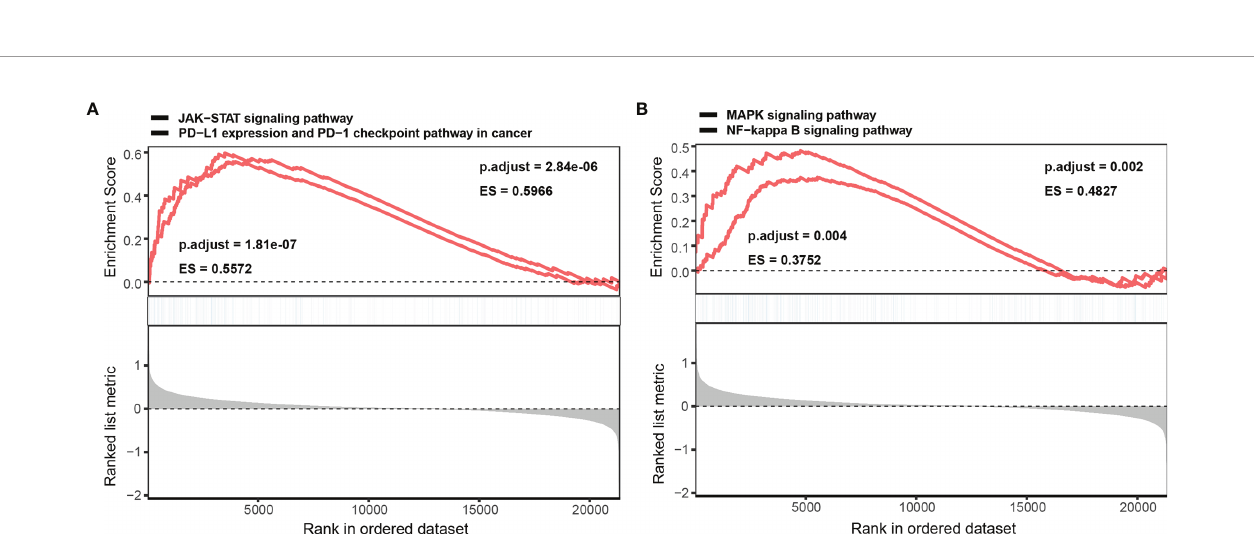
FIGURE 6 | GSEA enrichment analysis of NINL. Single gene GSEA enrichment analysis of NINL, four signi fi cant pathways are listed (A, B)